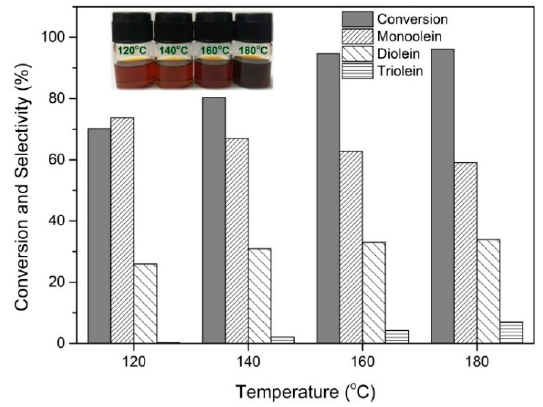
Figure 6. Effect of reaction temperature on oleic acid conversion, product distribution, and product color using S-N 2 -HPW catalyst in esterification of glycerol with oleic acid for 3 h using glycerol/oleic acid molar ratio of 4:1, 2.5 wt % of catalyst loading, and reaction temperatures of 120, 140, 160, and 180 °C.